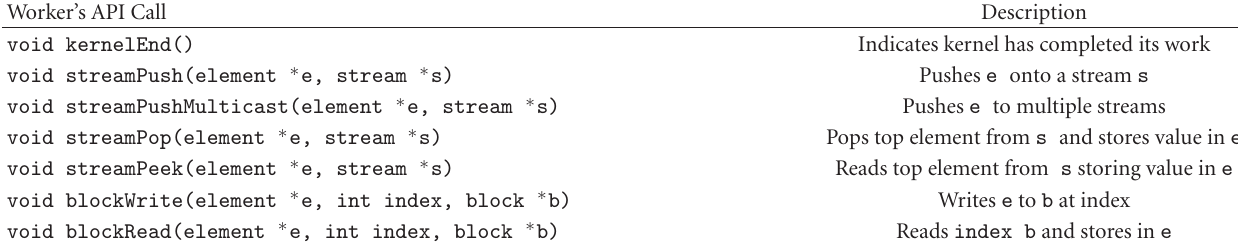
Table 2: Redsharc worker kernel’s API